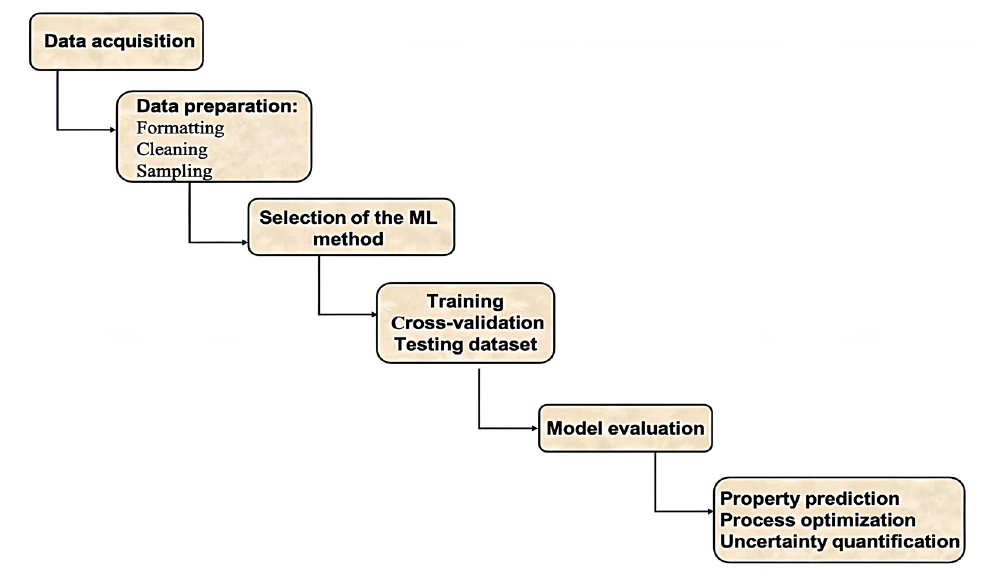
Figure 9. Scheme of the six-stage approach for the implementation of ML algorithms.